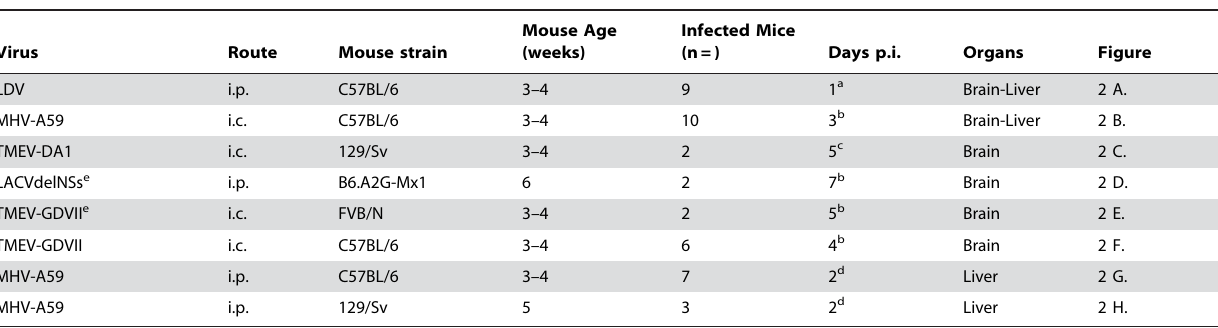
Table 2. Mouse infections with RNA viruses.